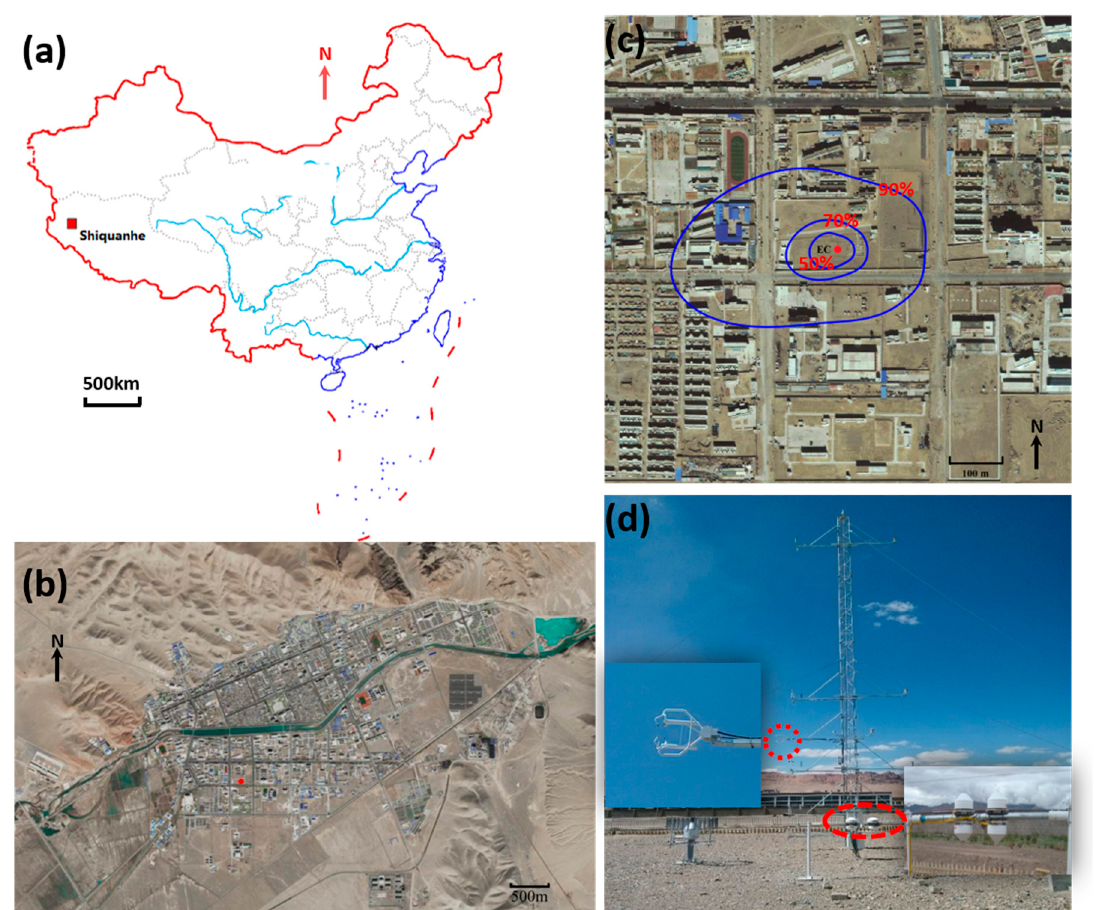
Figure 1. ( a ) The geographical location, ( b ) local topography, ( c ) underlying surface and footprint of surface turbulent fluxes, and ( d ) observation tower and instruments at the Shiquanhe site. The satellite map was from the website: